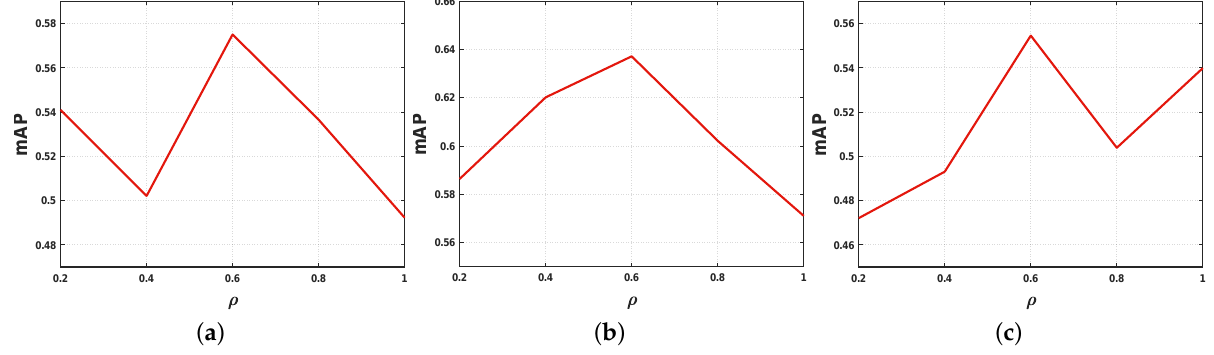
Figure 6. The mAP scores of HAAN in all datasets with ρ varying. ( a ) Corel 5K; ( b ) Pascal Sentence; ( c ) Wiki.